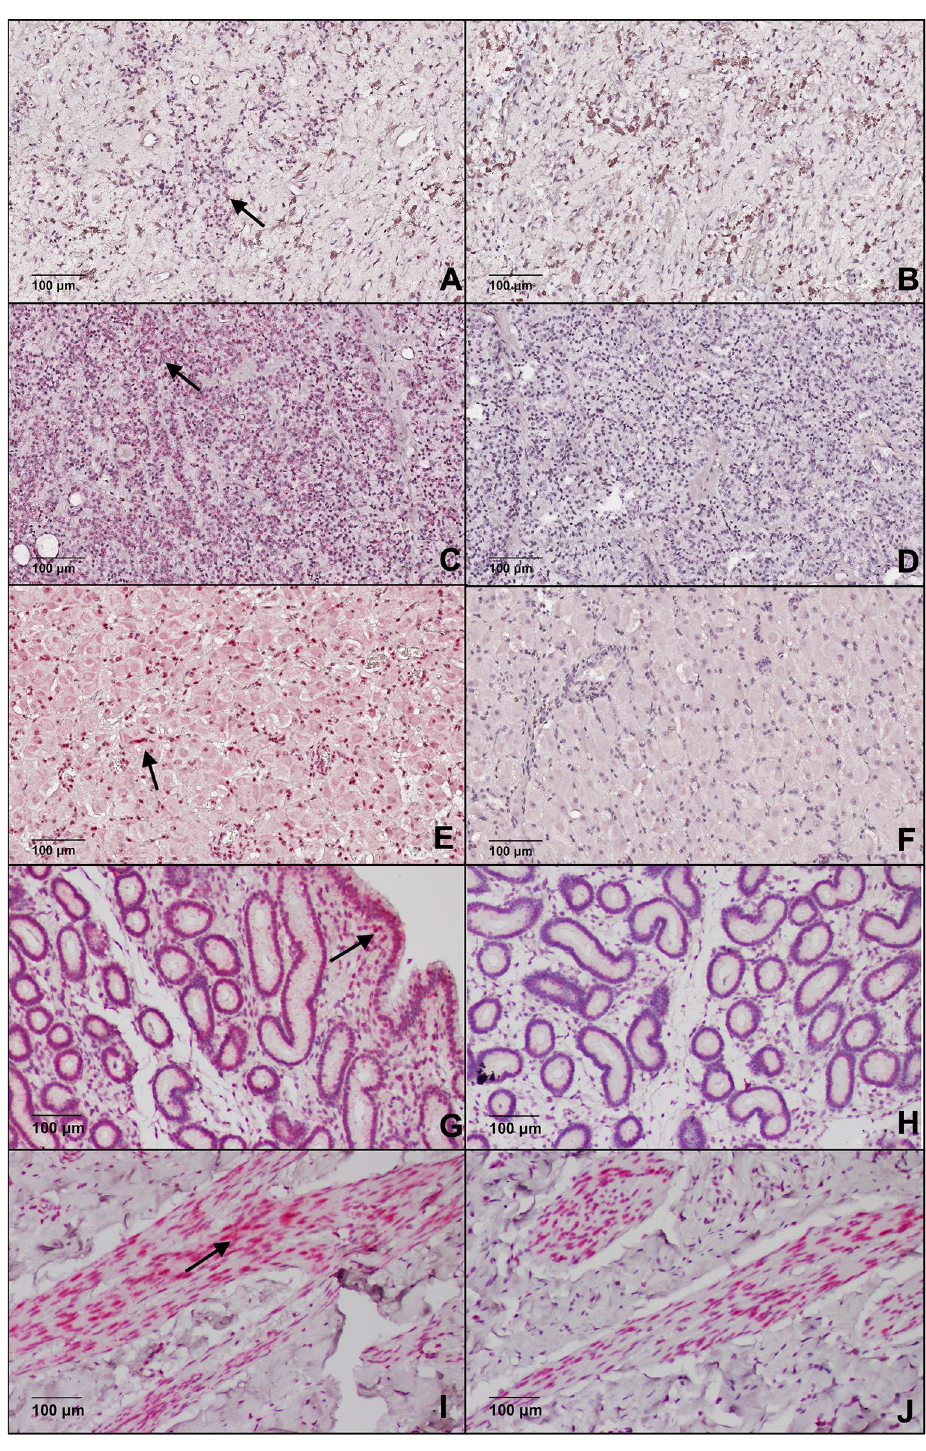
Figure 5. Photomicrograph demonstrating mRNA expression of LNPEP (pink dots) in: ( A ) posterior hypophysis, ( C ) anterior hypophysis, ( E ) corpus luteum, ( G ) endometrium and ( I ) myometrium. Black arrow shows specific staining. Control DAB for each tissue ( B , D , F , H and J